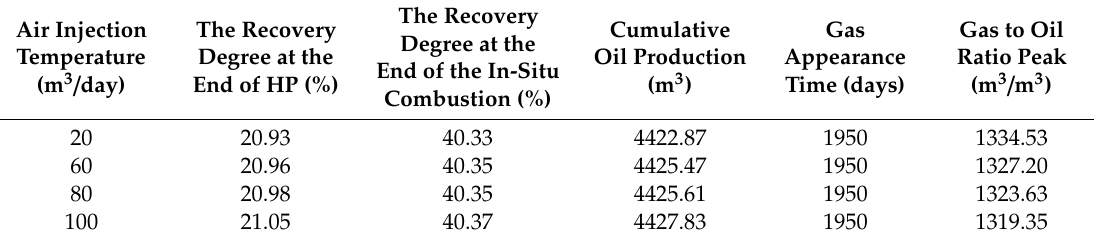
Table 8. Dynamic production index under di ff erent air injection